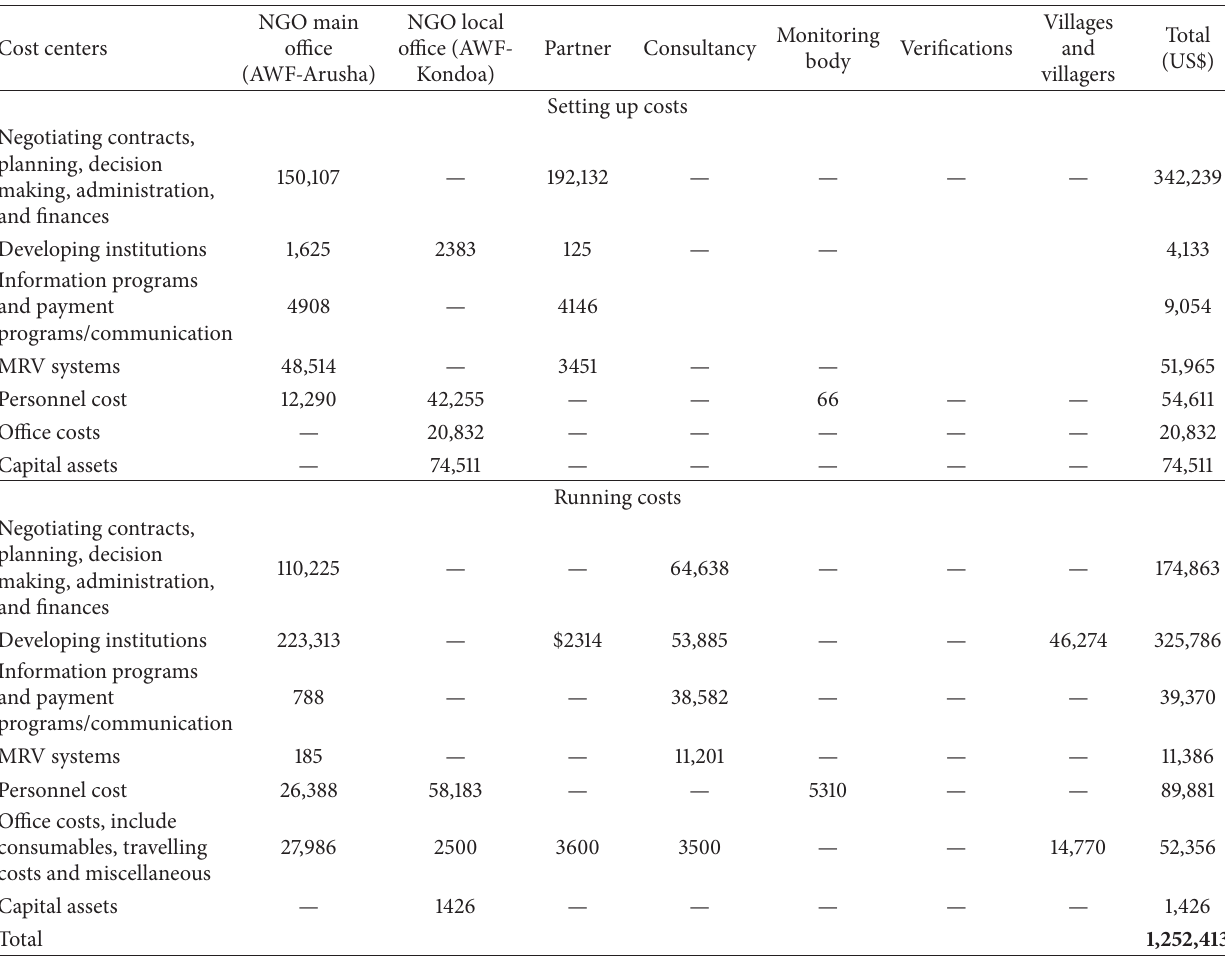
Table 2: Setting up and running costs of the ARKFor pilot project from 2010 to